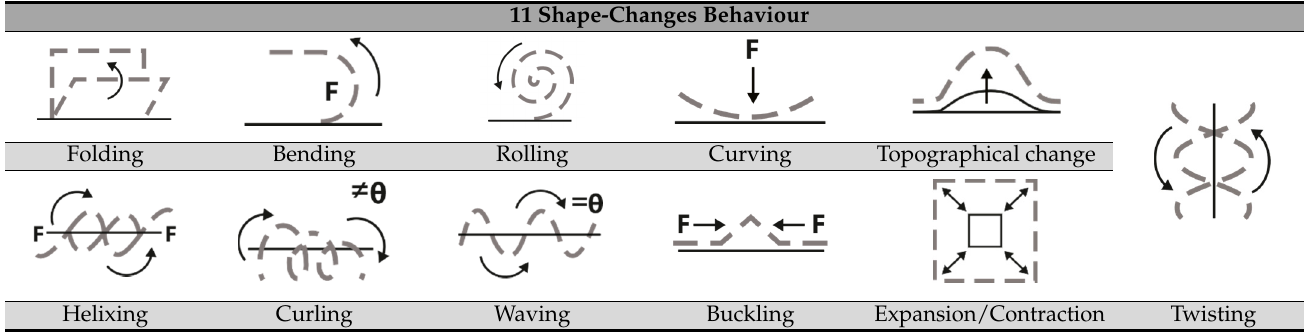
Table 3. The most preferred 4D Printing 11 shape-changes behaviours symbol.